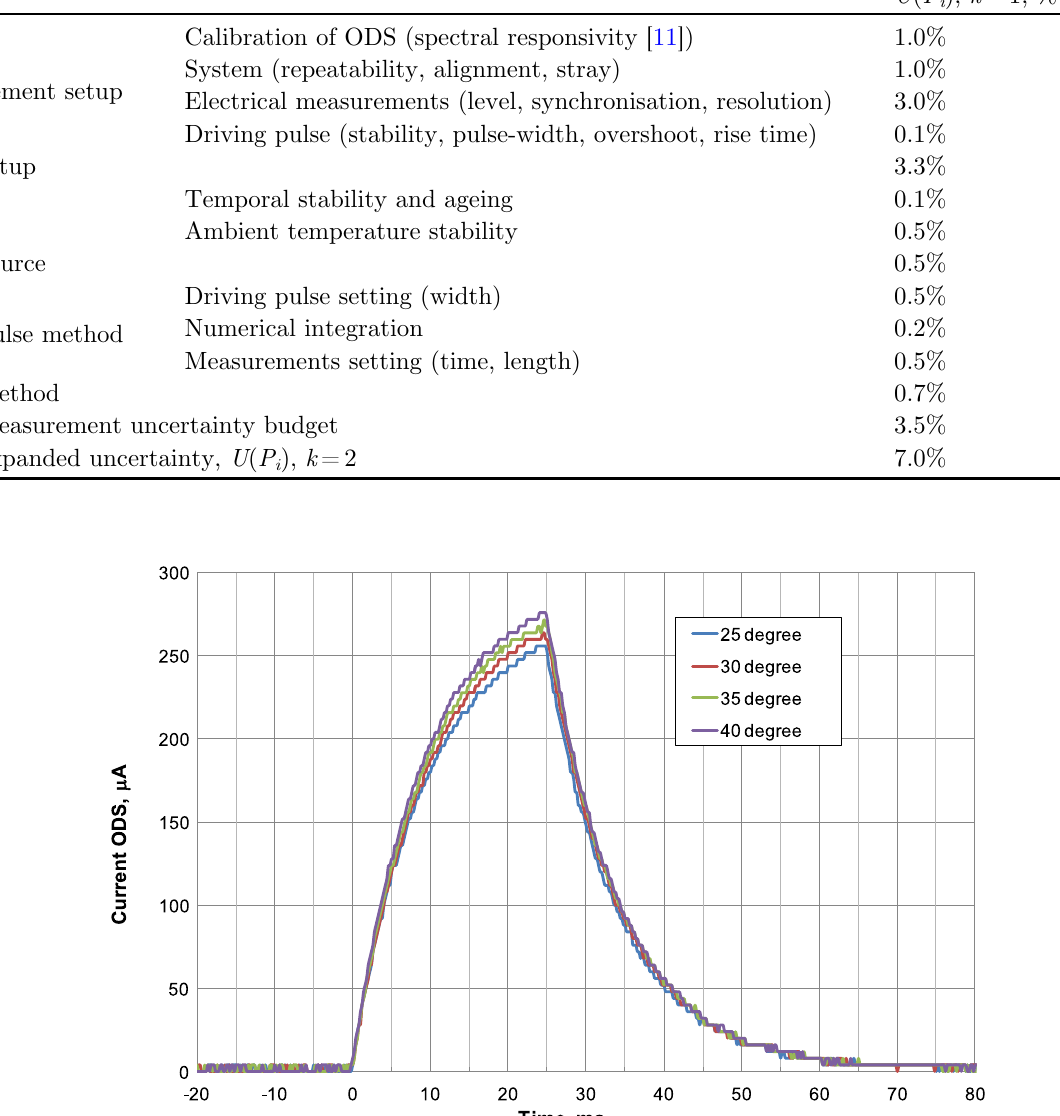
Fig. 13. Dependence of the optical output of the VSL096 from ambient temperature change when driven by a short-pulse and sensed by the fi lter F488 of the